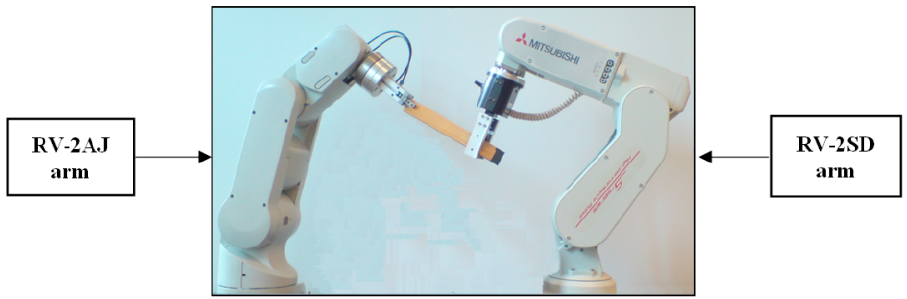
Figure 5. RV-2AJ robot aids the RV-2SD robot to get the necessary workpiece.